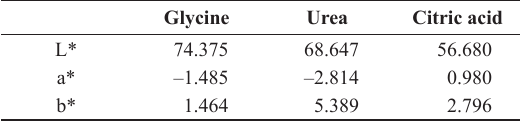
Table 2. Colorimetric coordinates